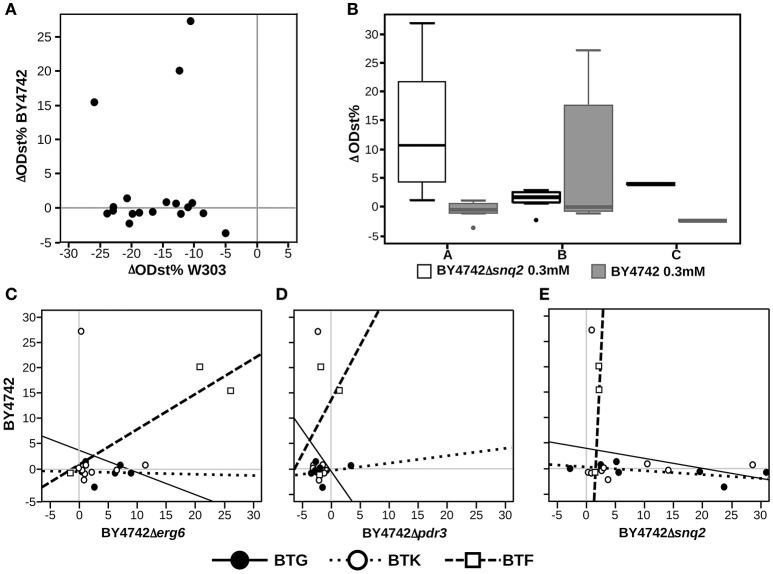
Highlights of the effects of the selected molecules and their chemical characteristics. (A) Direct comparison of the molecules effect on BY4742 and W303 strains, each dot indicate a different molecule; (B) boxplot showing the effects on the BY4742Δsnq2 strain culture ODst caused by the molecules grouped according to the scaffold classification showed in Figure 1A; (C–E) relationship between the effects induced by the molecules classified accordingly to Figure 1B on the wild-type BY4742 and on the Δerg6, Δpdr3, and Δsnq2 strains, respectively.